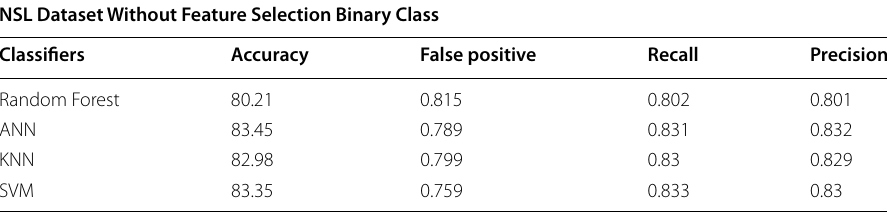
Table 13 Results on NSL dataset without feature selection algorithm NSL Dataset Without Feature Selection Binary Class